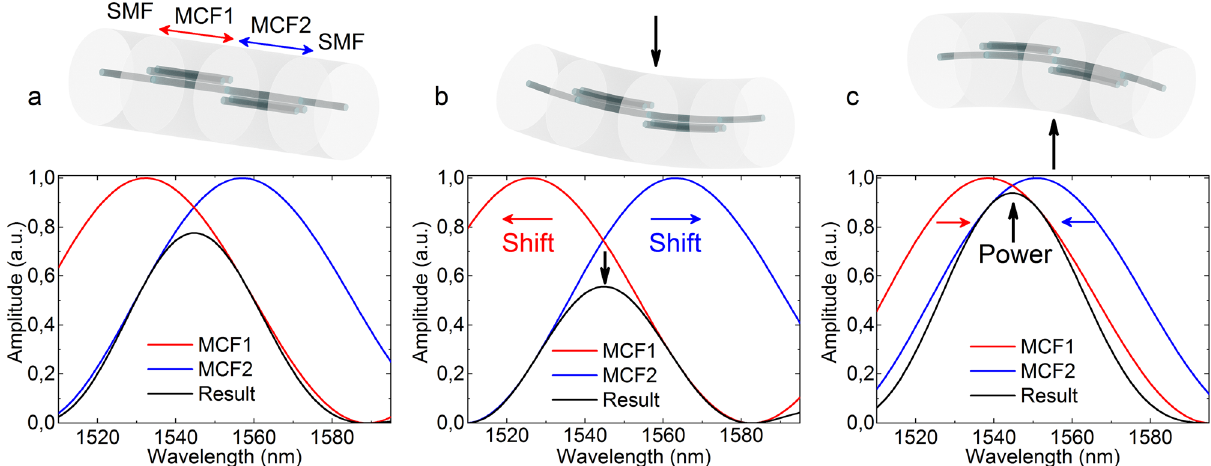
Figure 3. Simulated spectra of each of the MCF segments and the resulting spectra for the cases where the structure is ( a ) straight, ( b ) bent upwards and ( c ) bent downwards by its fusion splice point. The arrow indicates the bending direction, the wavelength shift or the power variation in each case. The cores of MCF1 are in a V-like configuration, whereas the ones in MCF2 are in an inverted V-like